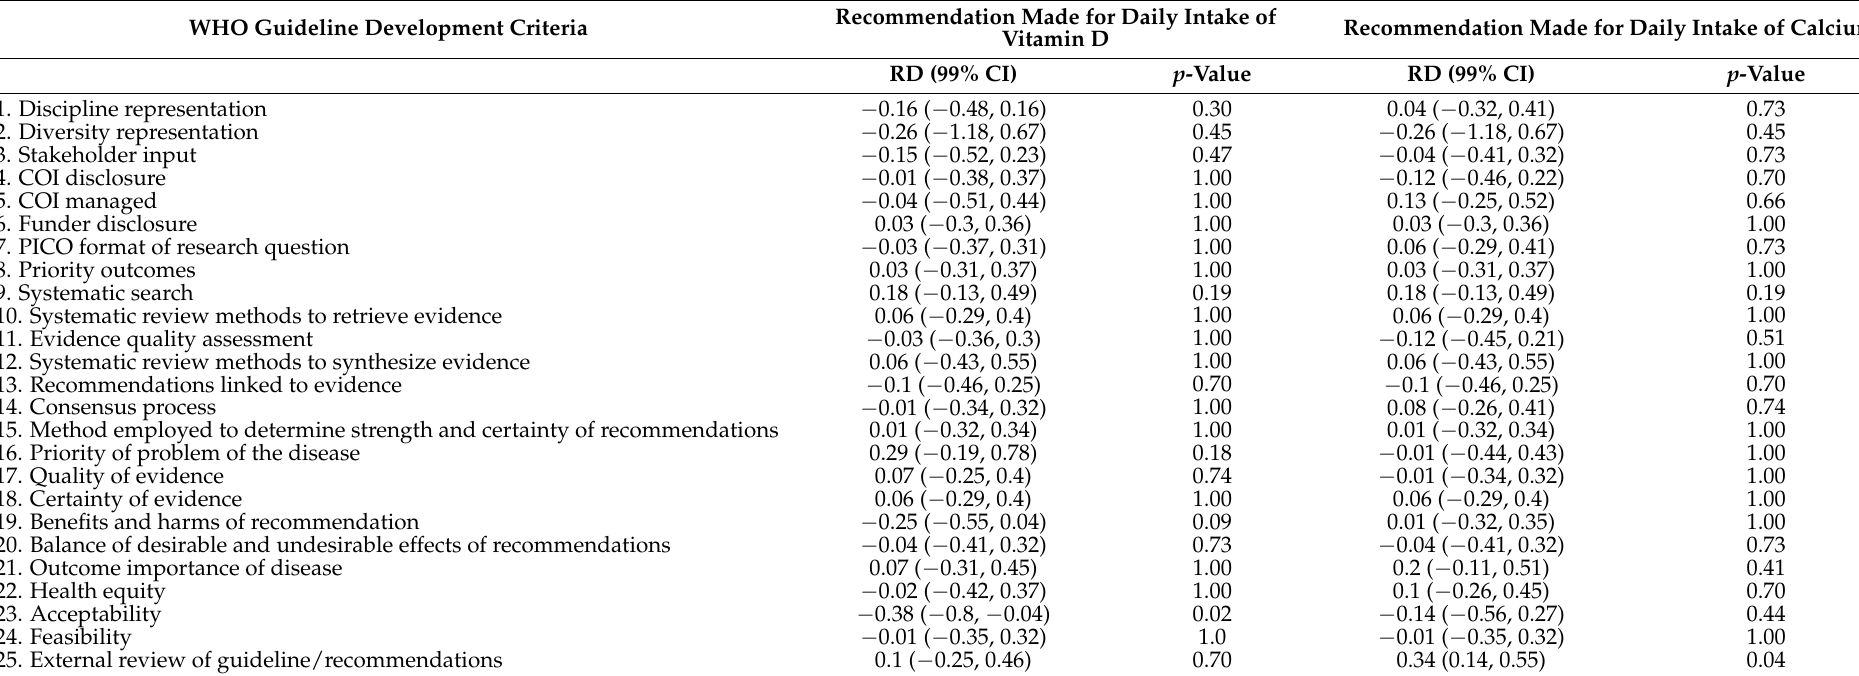
Table 4. Risk difference (RD) and its 99% confidence interval (CI) for the relationship between a guideline process that had met or not met a WHO guideline development criterion 1 and the recommendations made on vitamin D or